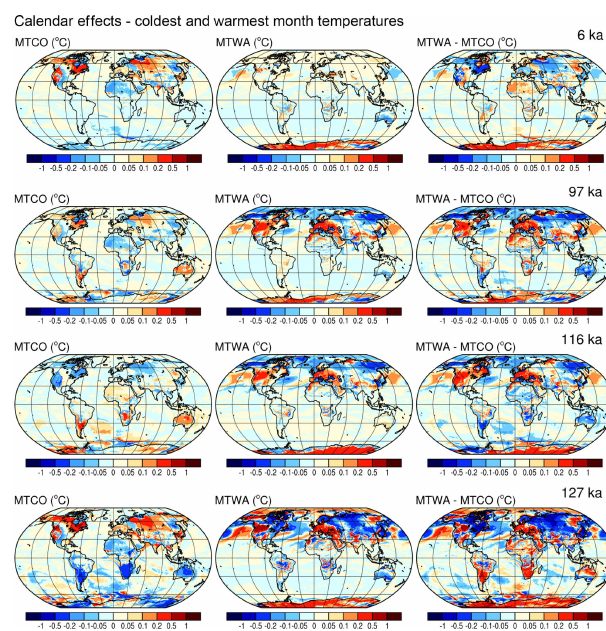
Figure 12. Calendar effects on the mean near-surface air tem- peratures of the warmest (MTWA) and coldest (MTCO) months and their differences (an index of seasonality) for 6, 97, 116, and 127ka (top to bottom row). The maps show the patterns of month- length adjusted average temperatures minus the unadjusted values for MTWA and MTCO using 1981–2010 long-term averages of CFSR tas values, with positive differences (indicating that the ad- justed data would be warmer than unadjusted data) in red hues and negative differences in